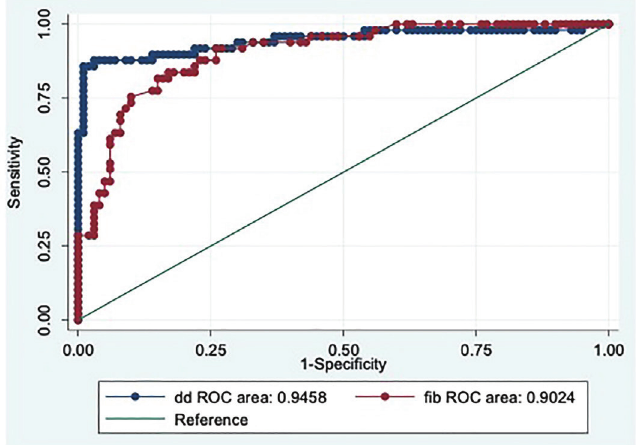
Figure 4 - ROC curve for detecting possible thrombosis when using the level of D-dimer and fibrinogen in the laboratory diagnosis of complications in patients with